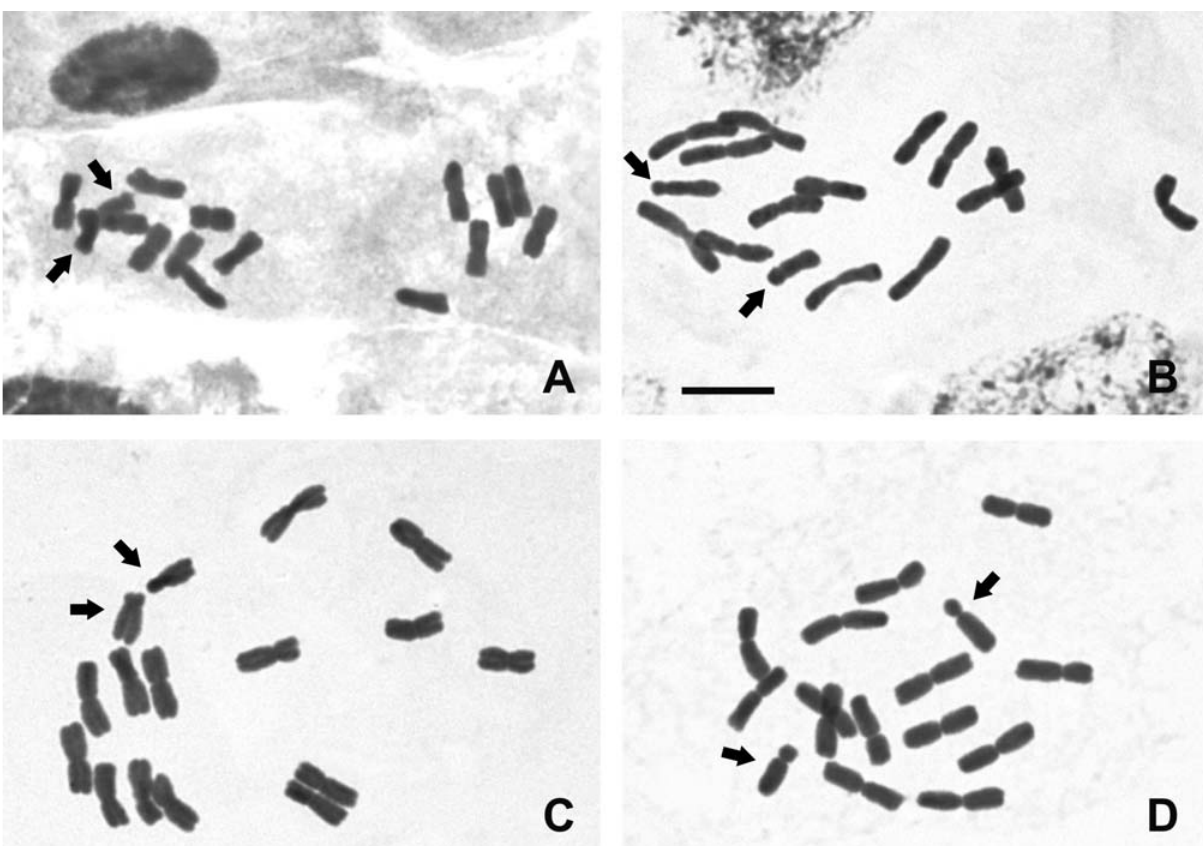
Figure 1 - Conventional staining in Cestrum species (2 n = 16): C. capsulare (A), C. corymbosum (B), C. laevigatum (C) and C. megalophylum (D). Ar- rows point to submeta-to-acrocentric pair 8 and some chromocenters in partial nuclei of C. corymbosum . Bar = 10 (cid:2)